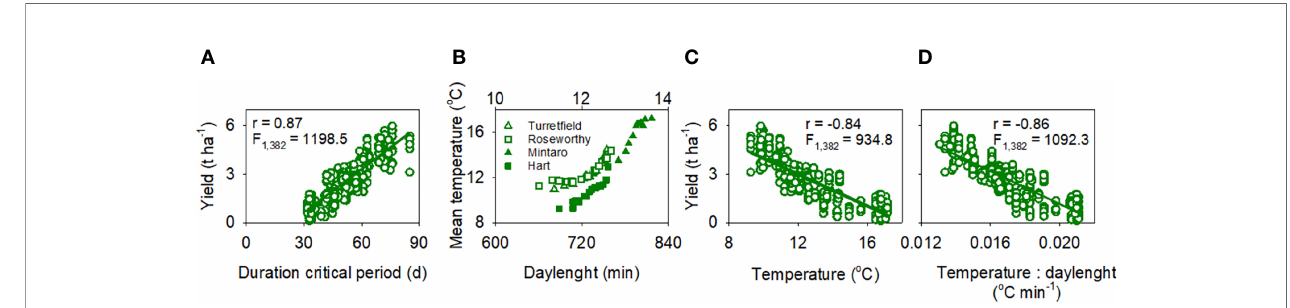
FIGURE 3 | (A) Spring-wheat yield was proportional to the duration of the critical period, from 300°Cd before to 100°Cd after fl owering (base temperature = 4.5°C). (B) The correlation between mean temperature during the critical period and daylength at fl owering varied with location and time of the year; the top x-axis shows